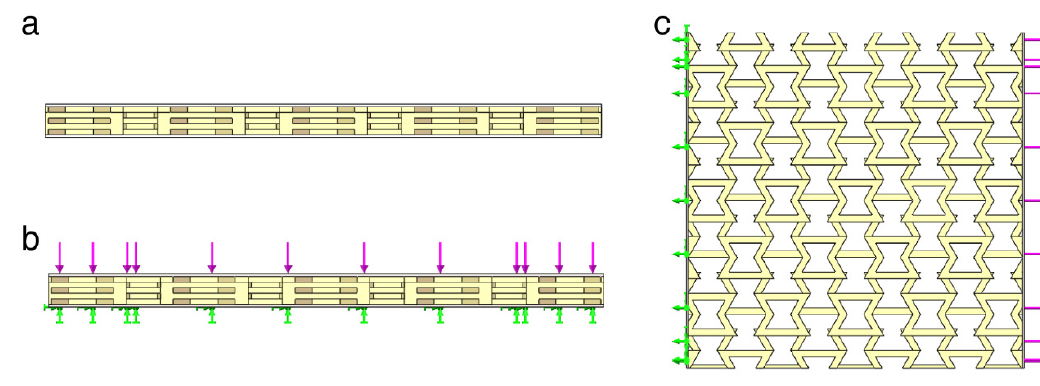
Figure 3. Simulation model ( a ) with pressure perpendicular to the upper surface of the scaffold ( b ) and tension parallel to the upper surface of the scaffold ( c ).